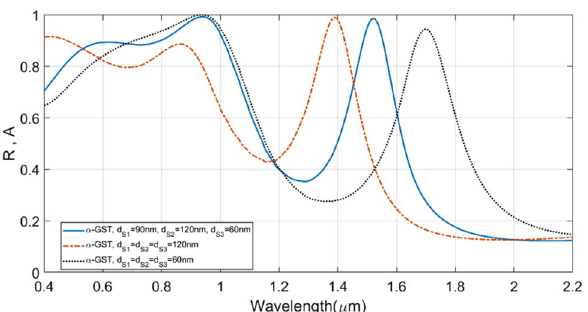
Figure 8. Plots of absorbance against wavelength for different values of d s1 , d s2 , and d s3 . The solid blue line corresponds to the optimum design with d s1 red line corresponds to the case of d s1 d s1 d s2 d s3 60 = = =